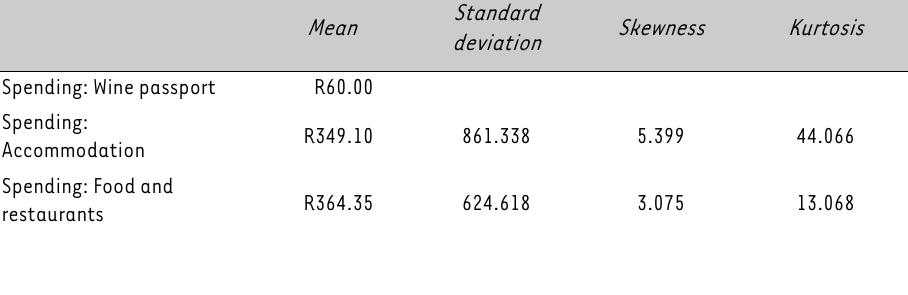
TABLE 2: Descriptive statistics for spending